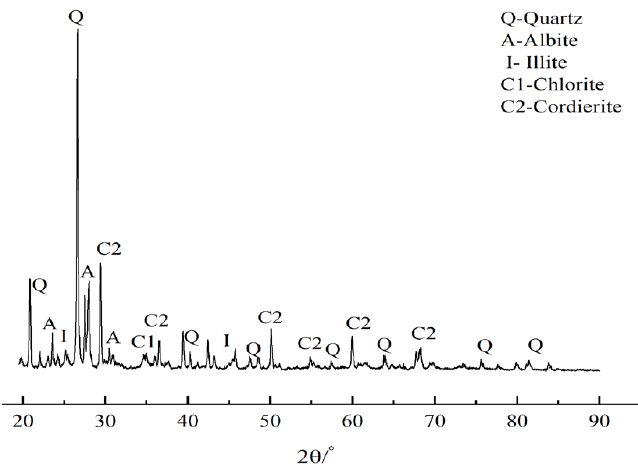
Figure 5. XRD diffraction pattern of loess.